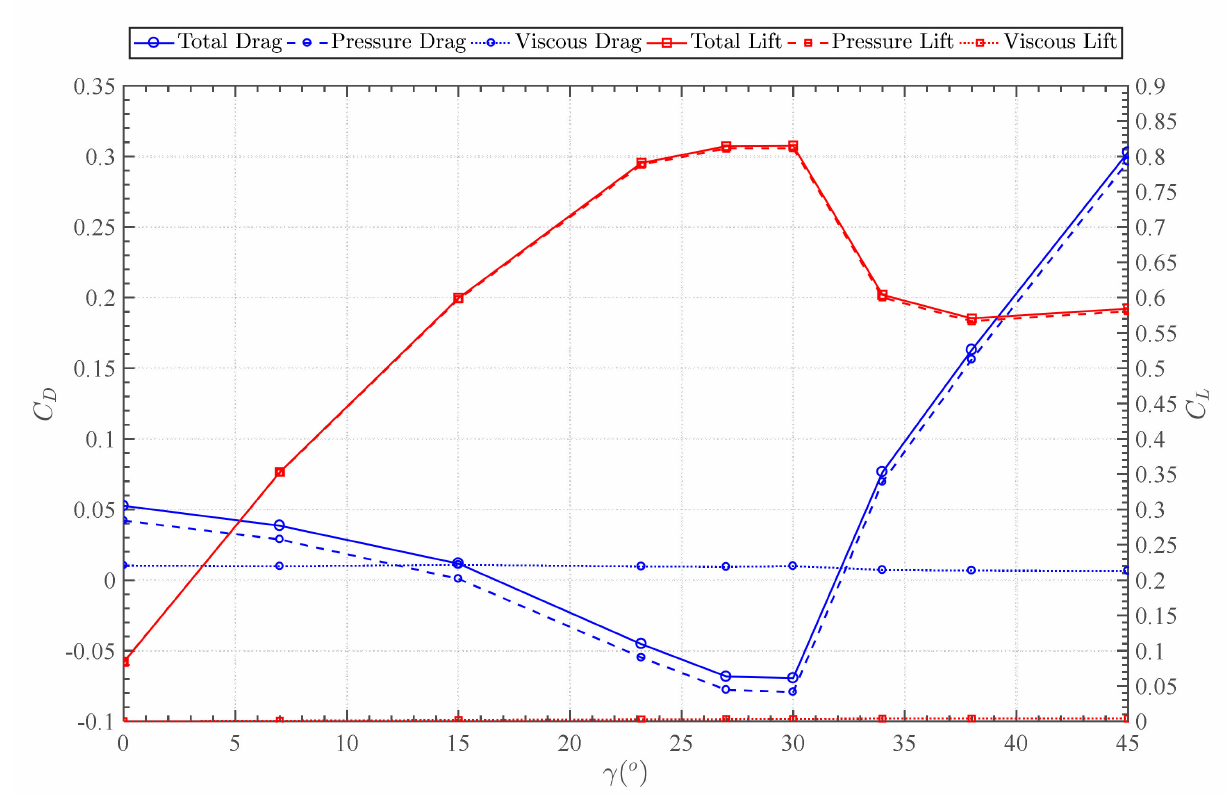
Figure 10. Evaluation of the duct drag coefficient ( C D ) and lift coefficient ( C L ) with yaw bearing ( γ ) within a free-stream velocity ( U ∞ ) of 4 m.s − 1